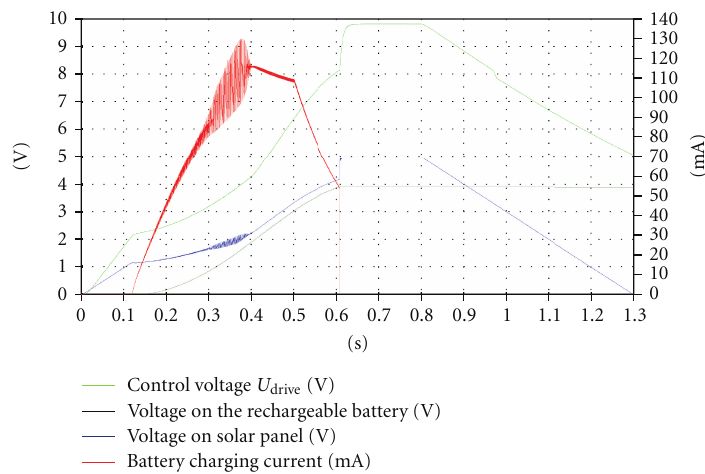
Figure 4: Simulation of the regulator critical values charging the rechargeable battery from solar cell.